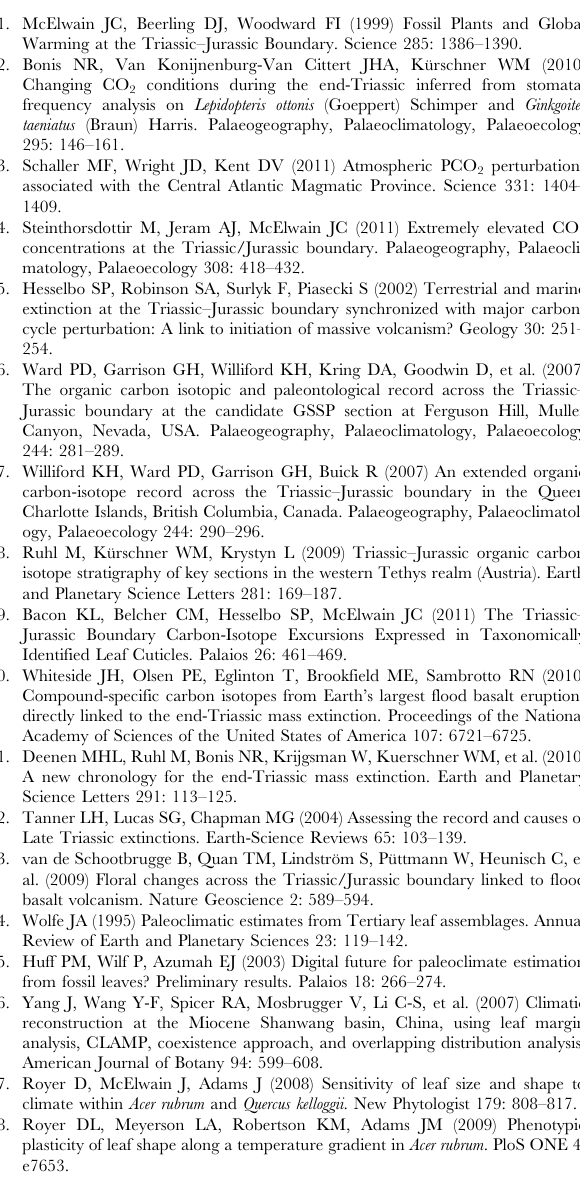
Table S32 Kruskal Wallis and Mann-Whitney U pair-wise comparisons for area in Ginkgoites in the different beds in which leaves are present at Astartekløft, East Greenland. Table S33 Kruskal Wallis and Mann-Whitney U pair-wise comparisons for perimeter in Ginkgoites in the different beds in which leaves are present at Astartekløft, East Greenland. Table S34 Kruskal Wallis and Mann-Whitney U pair-wise comparisons for shape factor in Ginkgoites in the different beds in which leaves are present at Astartekløft, East Greenland. Table S35 Kruskal Wallis and Mann-Whitney U pair-wise comparisons for compactness in Ginkgoites in the different beds in which leaves are present at Astartekløft, East